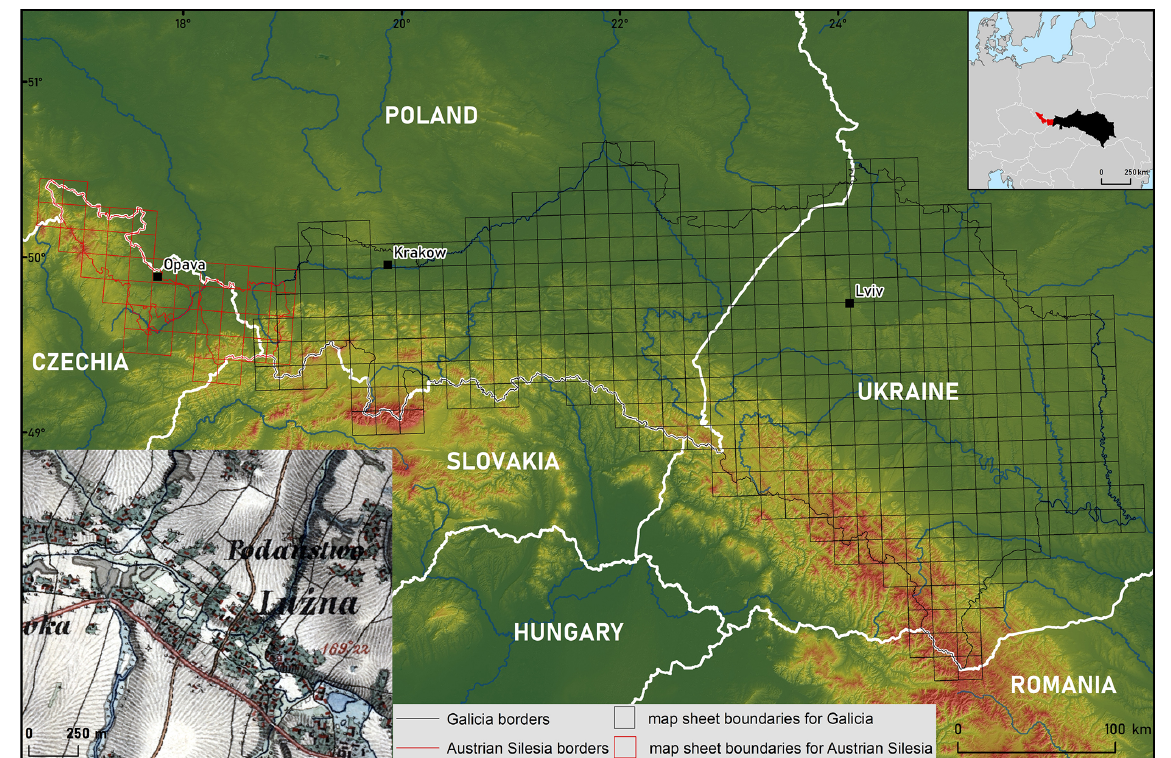
Figure 1. Study area; lower left corner presents a small portion of the maps used in the study (source: Austrian State Archives).